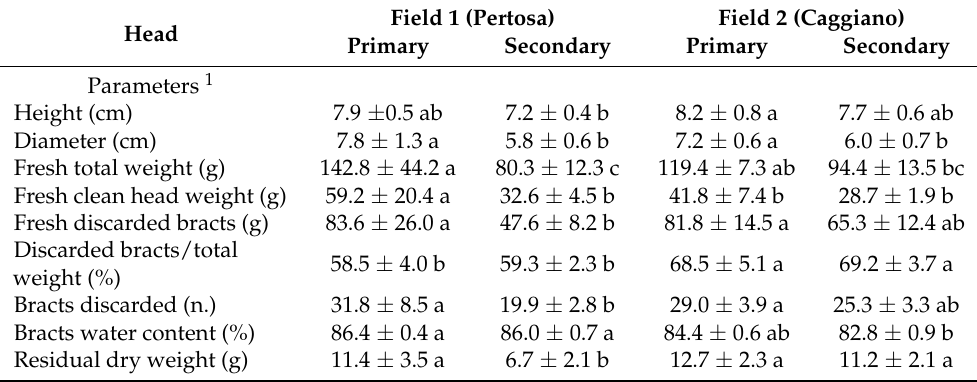
Table 1. Results of the surveys carried out on heads at harvest and on processing